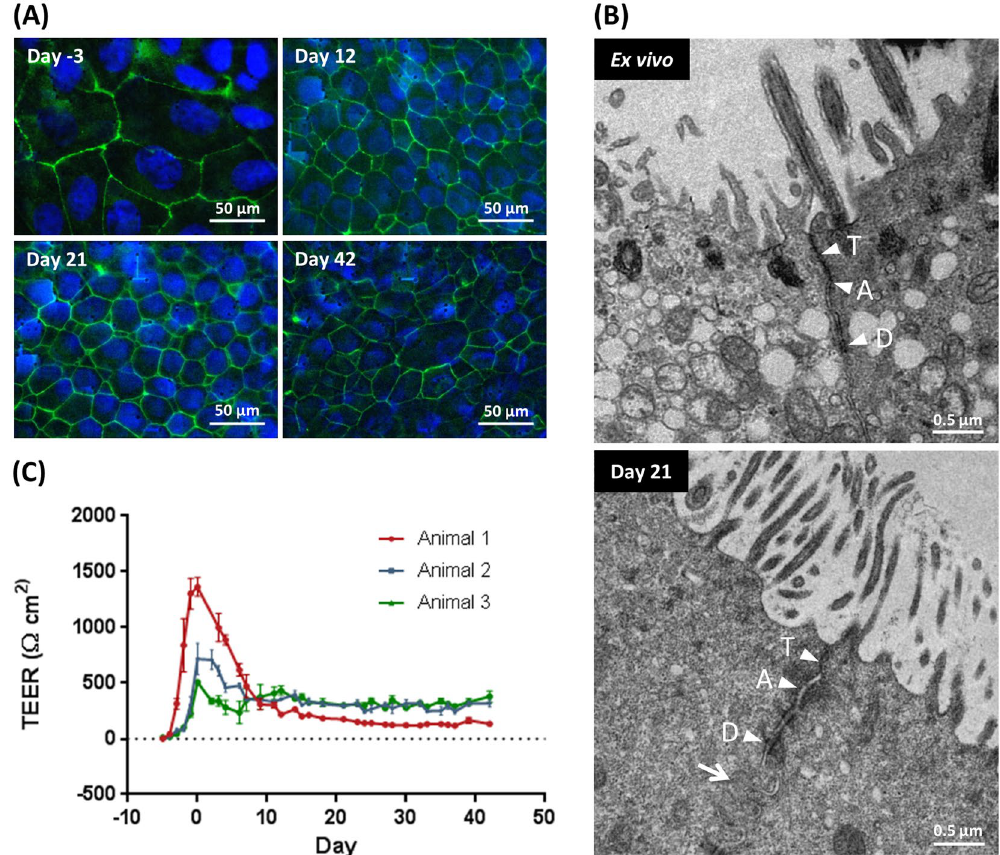
Figure 3. Tight-junction formation and changes in barrier function in BBEC cultures over time. Bronchial epithelial cell cultures were grown for the indicated number of days at an ALI (relative to the establishment of the ALI) and fixed in situ on the membranes. In ( A ) tight-junction formation was subsequently assessed using immunofluorescence staining of the tight-junction protein ZO-1 (tight junctions - green; nuclei - blue). Representative images are shown of BBECs at − 3, 12, 21 and 42 days post-ALI (see also Fig. S4). In ( B ) junctional complexes of ex vivo bronchial epithelial tissue and day 21 post-ALI BBEC cultures were assessed by TEM. Tight-junctions (T), adherens junctions (A) and desmosomes (D) were present along the apicolateral borders of epithelial cells in both the ex vivo tissue and BBEC cultures. In addition, membranous interdigitations (arrow) were observed between adjacent cells in the BBEC cultures. In ( C ) tight-junction integrity during the course of epithelial cell proliferation and differentiation was assessed by measuring the TEER of BBEC cultures until day 42 post-ALI. Nine inserts were analysed per time-point and the data represents the mean + / − standard deviation from tissue derived from three different animals (n =